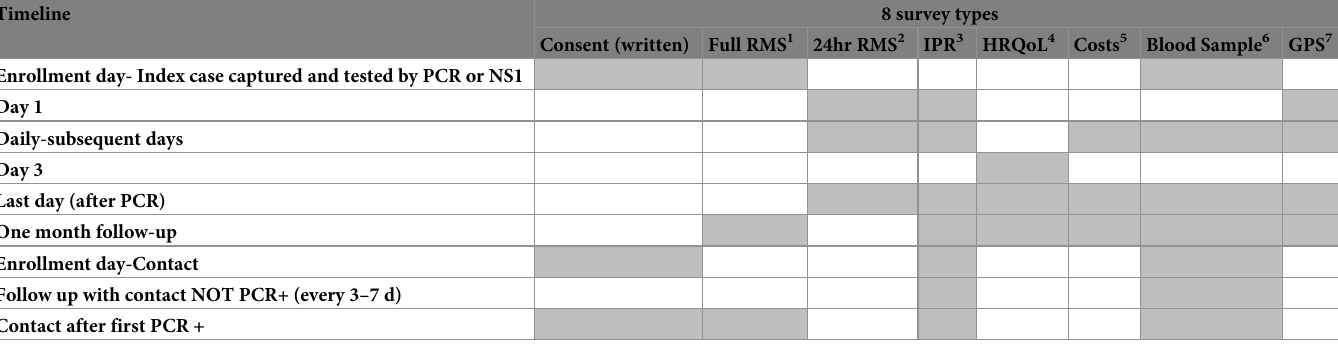
Table 1. Interview workflow for 8 survey types using surveys developed for CommCare [41] and deployed on mobile tablets running Android OS [51], each ques- tionnaire was administered verbally by trained research staff, who recorded their responses using the application. Shaded cells denote when surveys were applied.